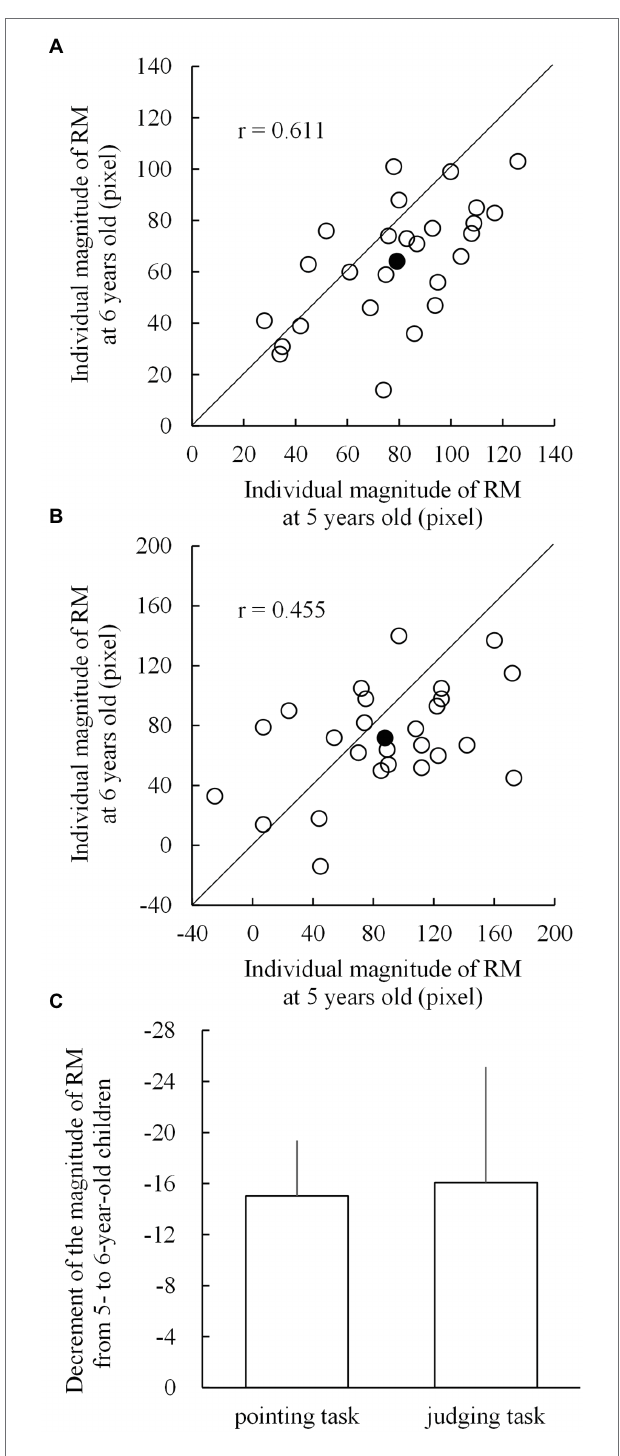
FIGURE 4 | Scattergrams for the individual magnitudes of representational momentum (RM) at the age of 5 (horizontal axis) and 6 years (vertical axis) in (A) the pointing task and (B) the judging task. The blank circles below the diagonal lines indicate individuals who showed a decreased magnitude of RM from 5 to 6 years of age. The filled circles indicate the mean magnitudes of RM. (C) Shows the respective mean decrements from 5 to 6 years of age for the pointing and judging tasks, with the error bars indicating 1 standard